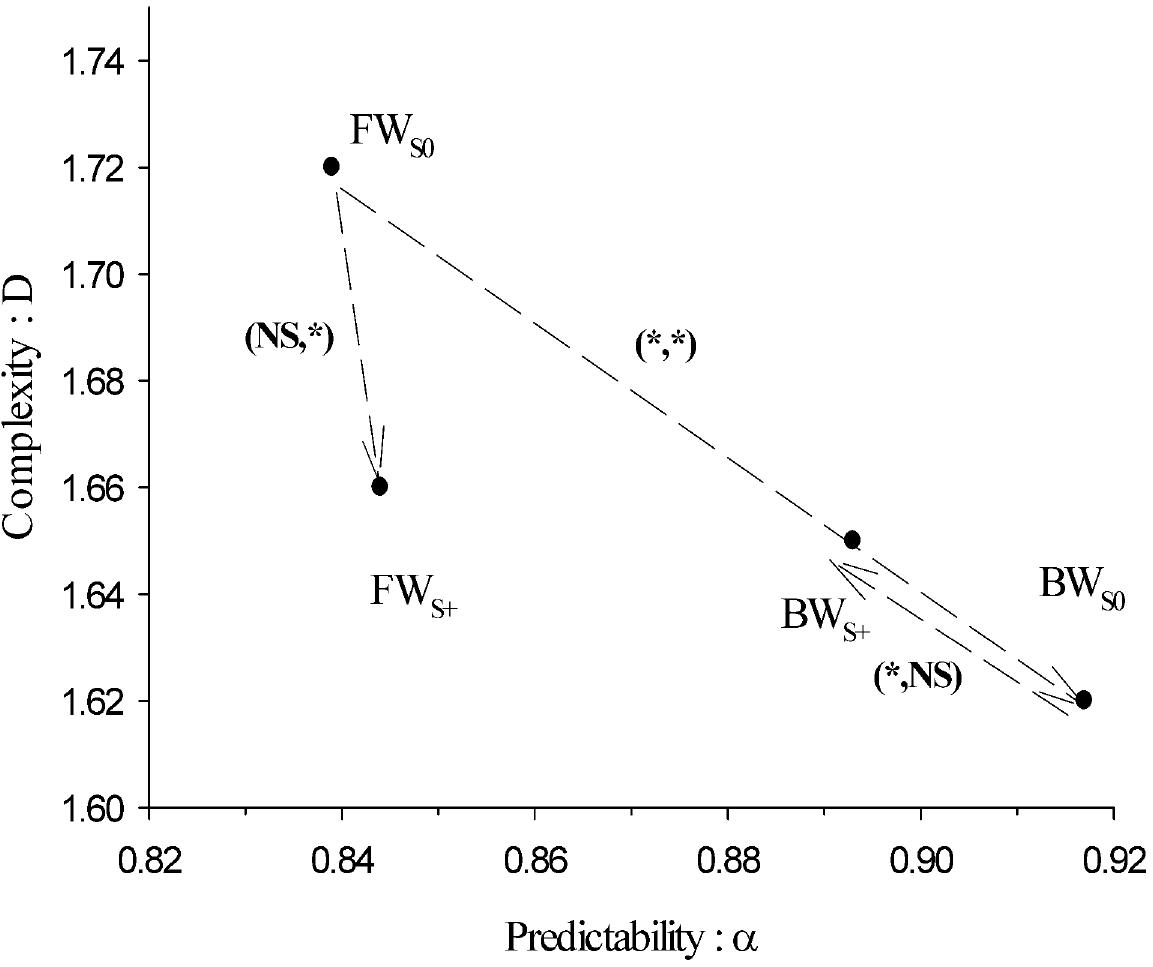
Fig 7. Evolution of the fractal dimension ( D ) versus the Hurst exponent ( α ) taken as complexity and predictability indices respectively for the four experimental conditions. Standarddeviations have not beenplotted for the sake of clarity. To guide the eyes, arrows indicate the four post-hoc comparisons performed with their significanceor not. The notation ( NS / * , NS / * ) denotes statistically significantdifferences ( * ) or no ( NS ) in the ( α , D )–plane.